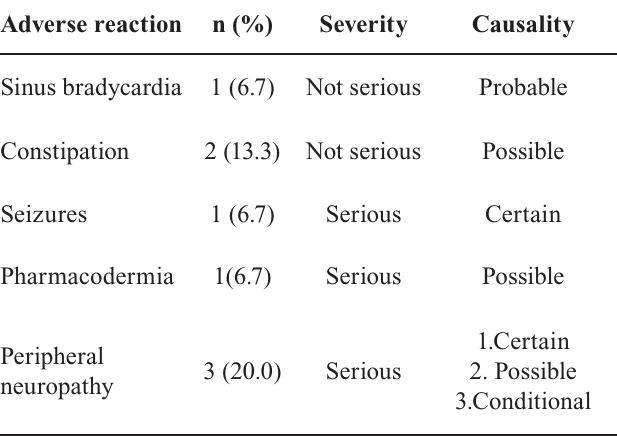
TABLE III - Notification of adverse events related to the use of thalidomide (n = 15)